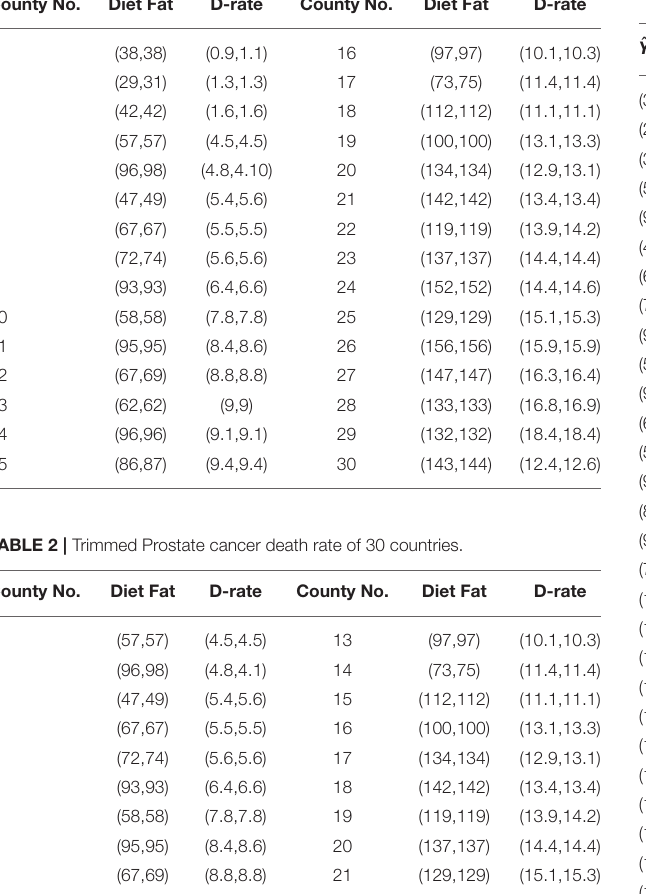
TABLE 1 | Prostate cancer death rate of 30 countries. County No.